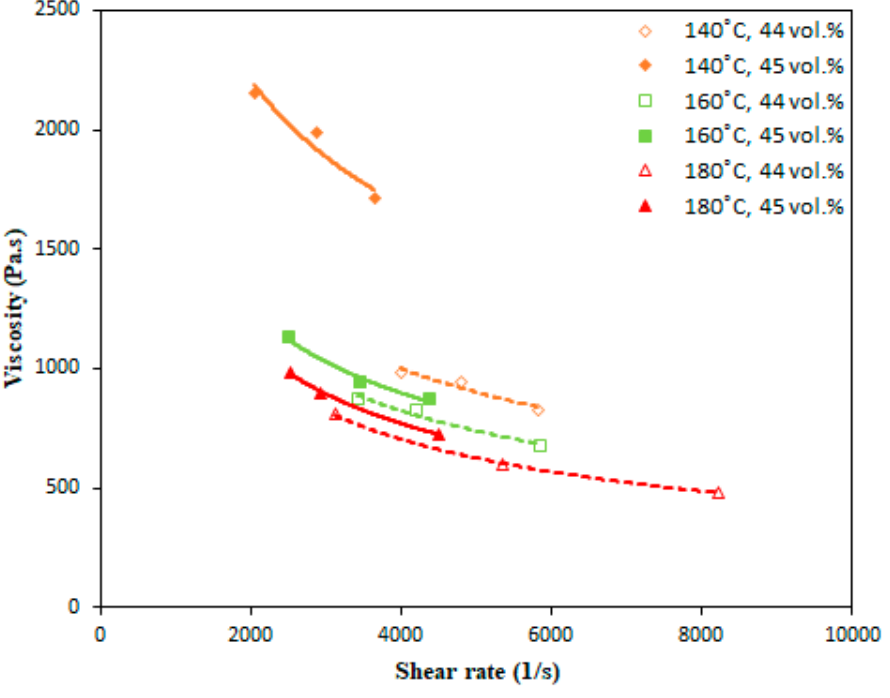
Figure 6. Relationship between the viscosity and shear rate of the 3YSZ feedstocks. Table 2. Values of n for SS 17-4PH and 3YSZ feedstocks at di ff erent temperatures. Feedstocks Optimal Powder Loadings